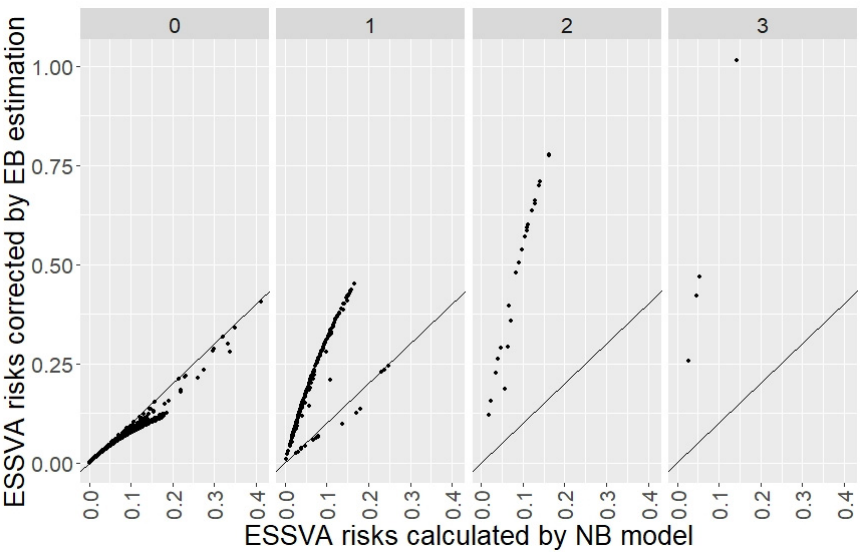
Figure 5. Comparison of ESSVA risks (the expected numbers of ESSVAs) according to the actual number of ESSVAs (0–3 from left to right) in the risk estimation period (nine years).